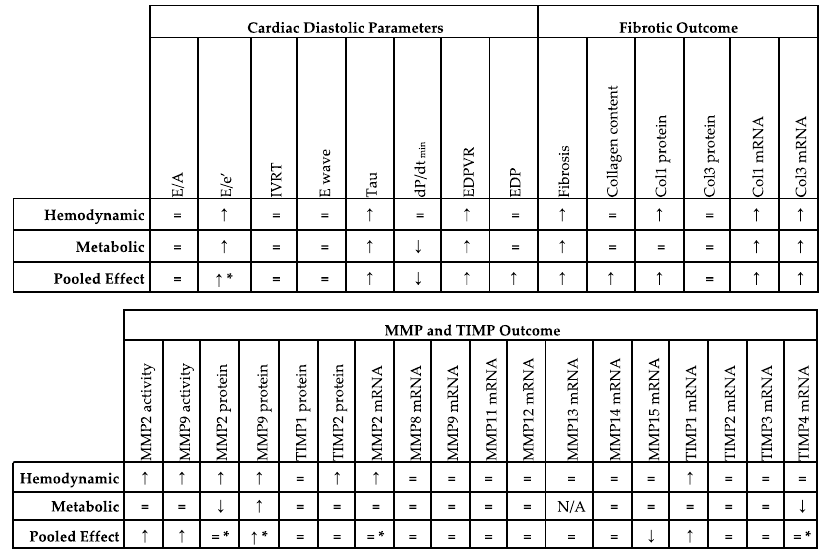
Table 1. Summarizing table of meta-analysis.